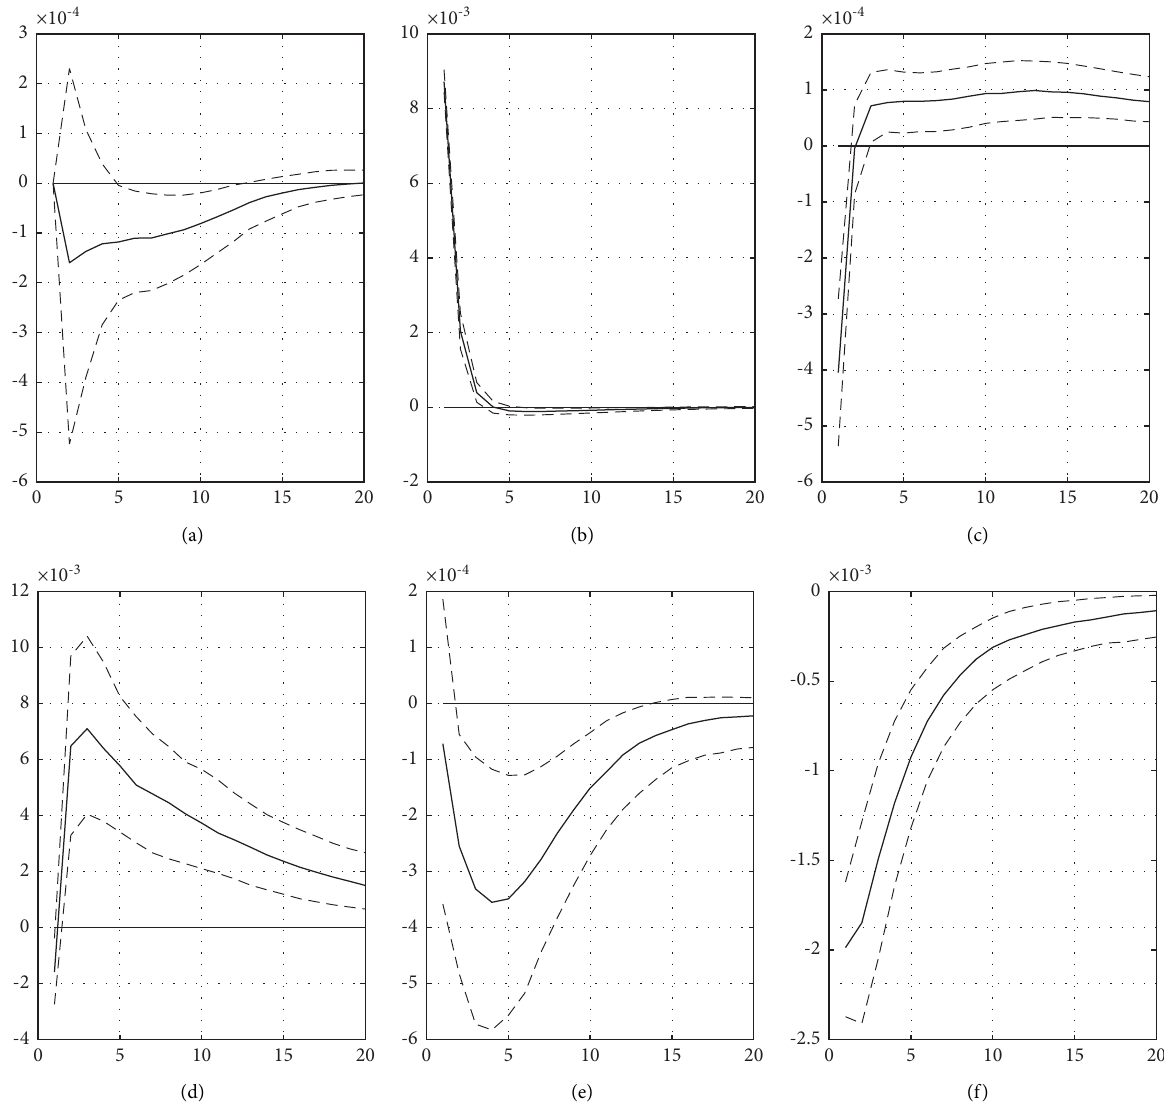
Figure 1: IRFs of Chinese economic variables to U.S. trade policy uncertainty shocks. (a) MPU. (b) TPU. (c) GDP. (d) Investment. (e) Consumption. (f)